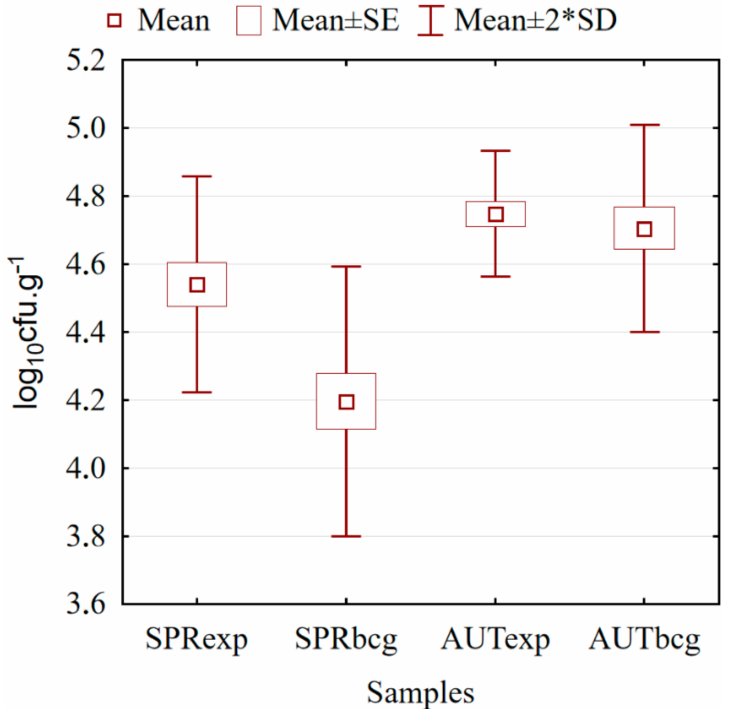
Figure 3. Average values of soil fungi in samples from experimental plots and background areas. Note: * SPRexp—experimental in spring; SPRbcg—background in spring; AUTexp—experimental in autumn; AUTbcg—background in